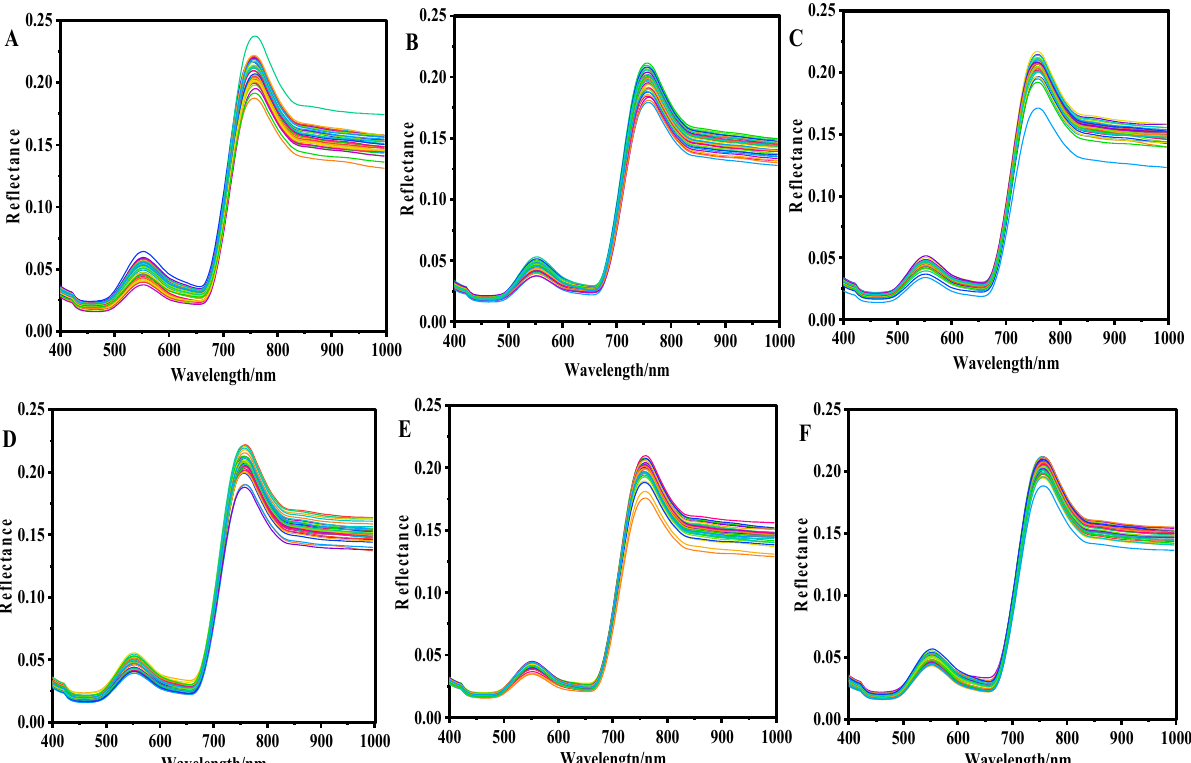
Figure 3. Raw spectra of chlorophyll content of muskmelon leaves under different light matter treatments. ( A – F ) The raw spectrum of chlorophyll content of muskmelon leaves under different light treatments: A—T1; B—T2; C—T3; D—T4; E—T5; and F—CK.